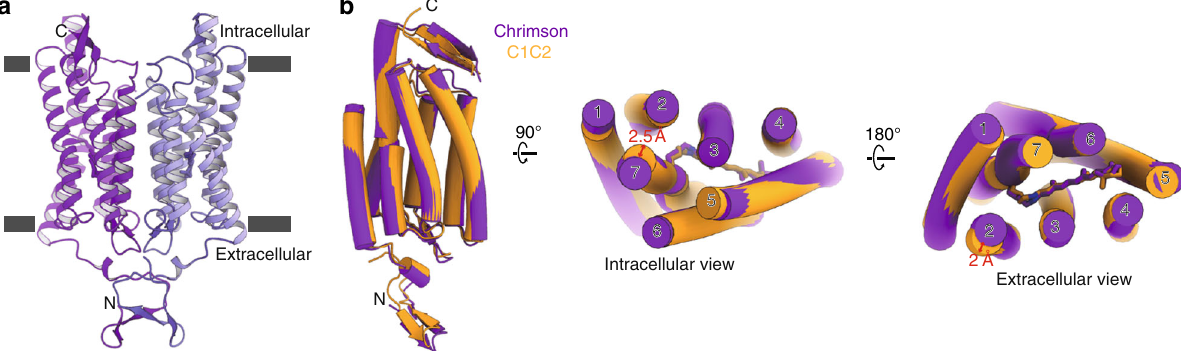
Fig. 1 Overall structure of Chrimson. a The dimeric structure of Chrimson is shown in ribbon models, with the two protomers in different colors. b Chrimson (purple) and C1C2 (orange) are superimposed, viewed from within the membrane plane (left), the intracellular side (center) and the extracellular side (right). The TM numbering is indicated on each helix, and the deviation of the helix termini for TM2 and TM7 are indicated by red